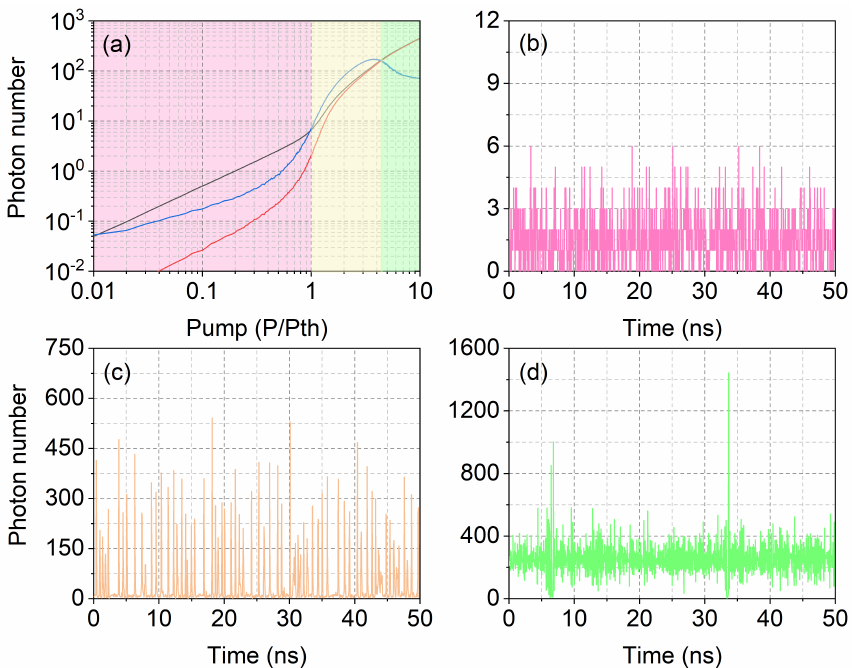
Figure 2. ( a ) Laser output as a function of (normalized) pump: average total emission (cid:104) L T (cid:105) (black); average stimulated emission (cid:104) L T (cid:105) (red); standard deviation of the stimulated emission σ L The yellow region extends from 1 ≤ P values: ( b ) 0.3 P th ; ( c ) 2 P th ; and ( d ) 6 P th ,